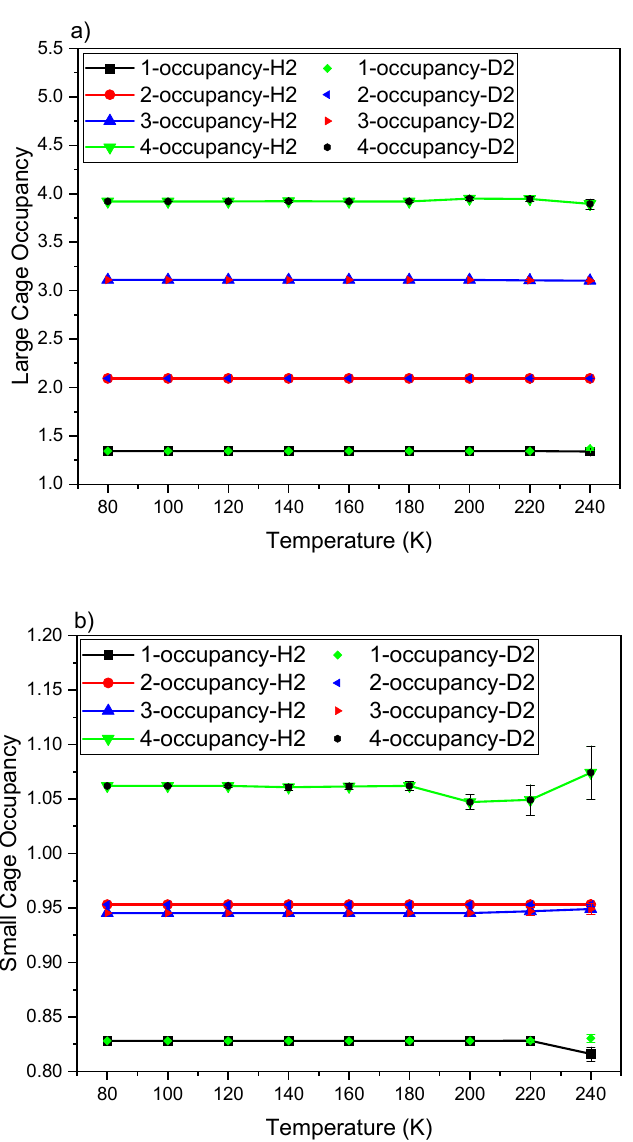
Figure 4. Cage occupancy averages vs temperature for large-cage occupancies ( a ) and small-cage occupancies ( b ) for hydrogen and deuterium.